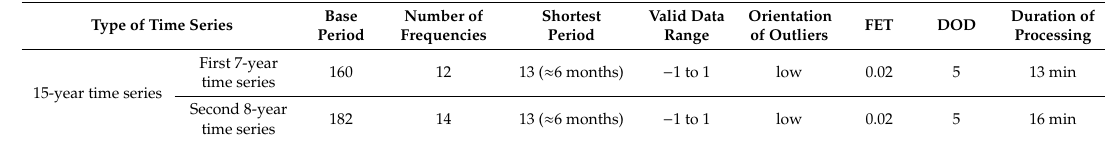
Table 1. Parameters used in HANTS algorithm.